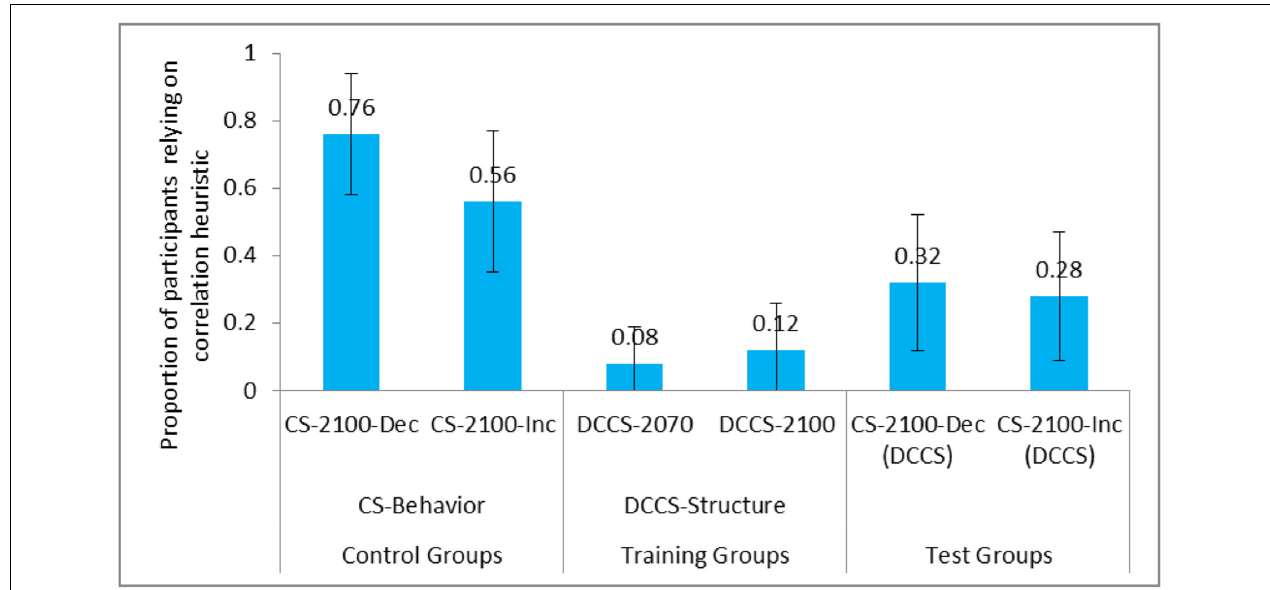
FIGURE 5 | Proportion of participants relying on correlation heuristic in CS tasks and DCCS in CS-Structure and DCCS-Structure conditions. The CS-2100-Dec (DCCS) task and CS-2100-Inc (DCCS) task refer to CS tasks following the DCCS performance in the DCCS-Structure condition. The error bars represent 95% confidence interval around the point estimate.